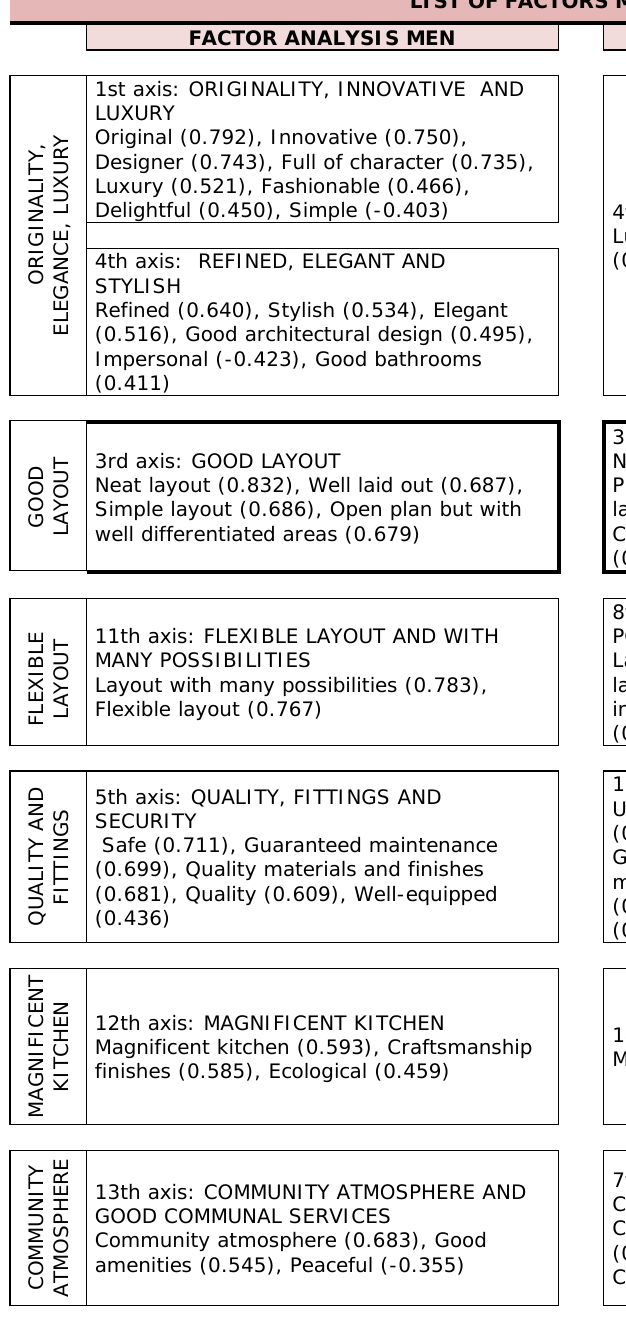
4th axis: LUXURY AND ELEGANT Luxury (0.711), Elegant (0.560), Refined (0.527), Classical and traditional (-0.417) 4th axis: REFINED, ELEGANT AND